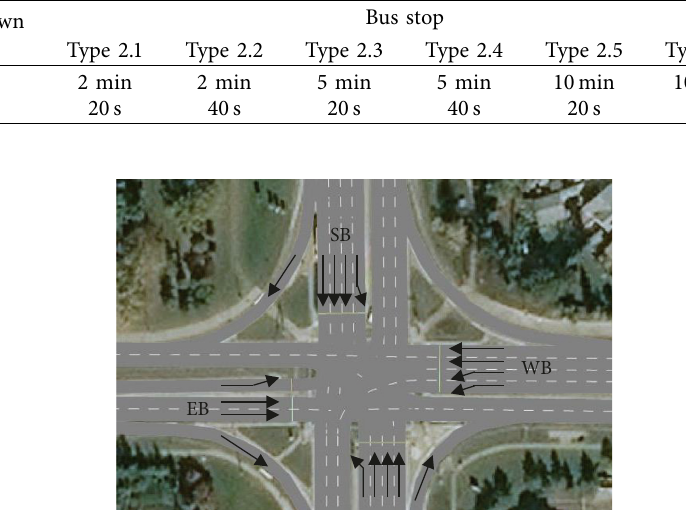
Table 2: Tested incident scenarios.